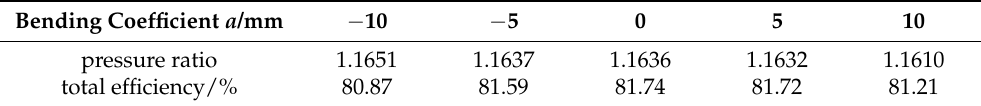
Table 5. Overall aerodynamic performance under near-blockage conditions.